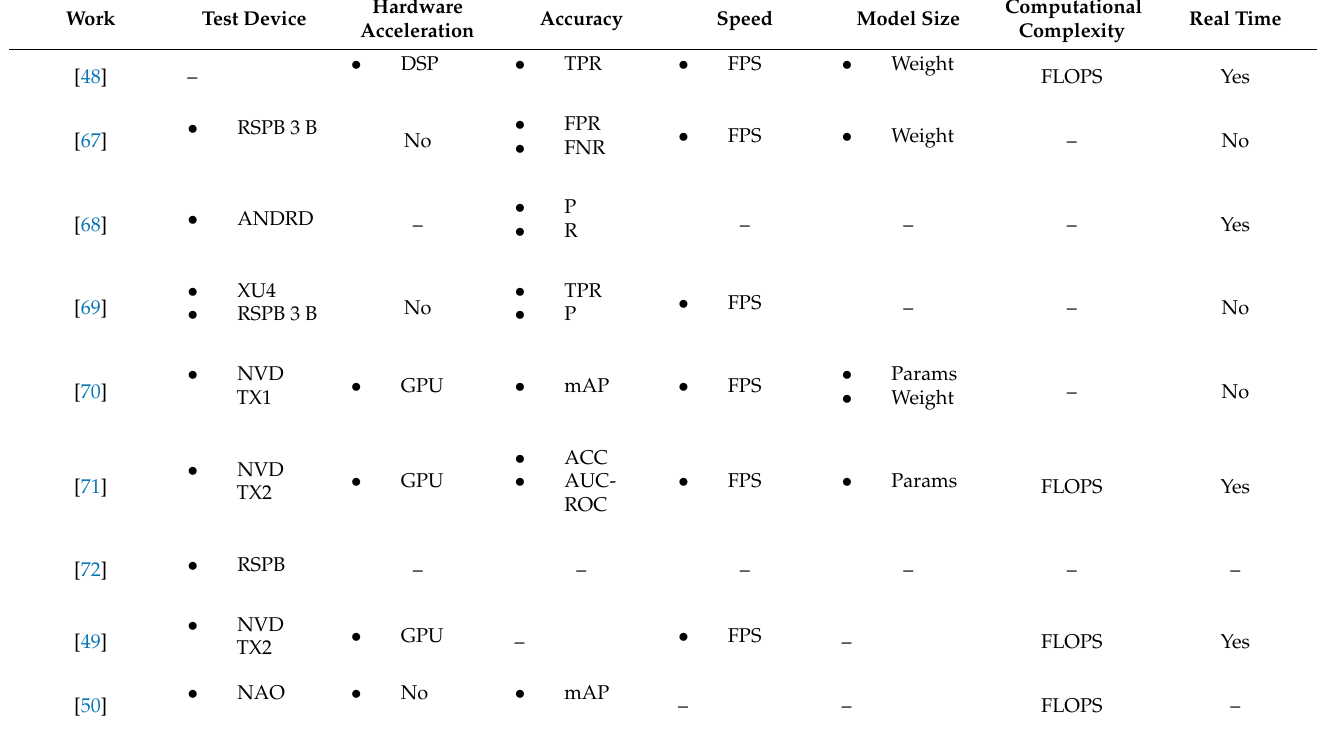
Summary of evaluation frameworks used for assessing on-device HAR models’ performance in the reviewed